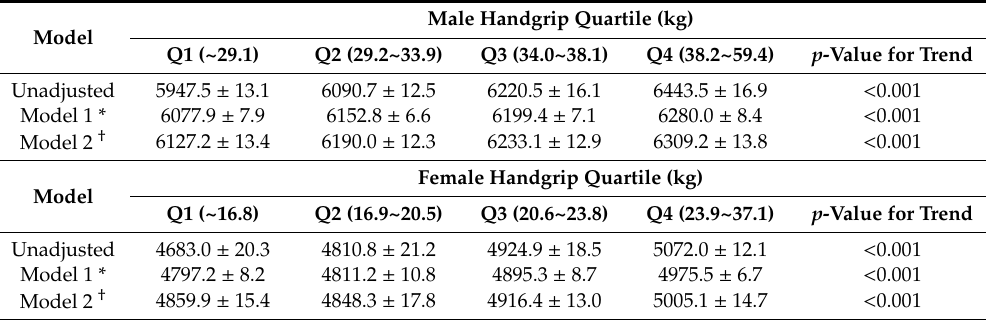
Table 5. Trend analysis of basal metabolic rate and handgrip strength quartile (kg).